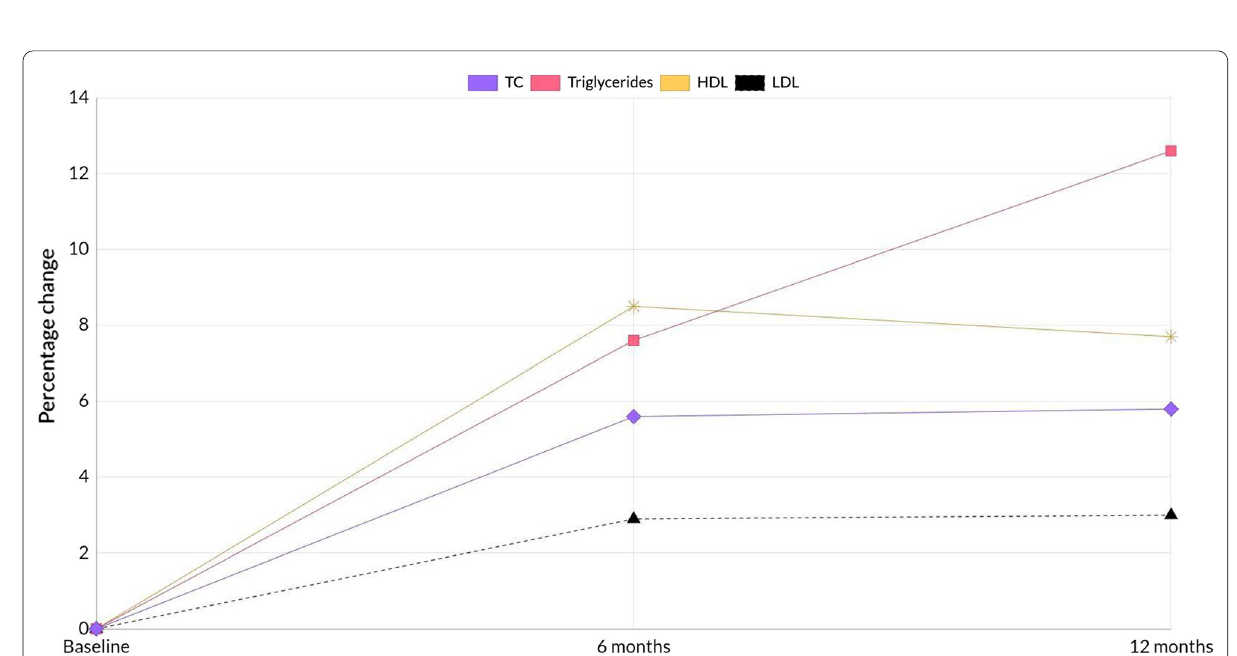
Fig. 3 The effect of medical castration on lipid levels in Spanish